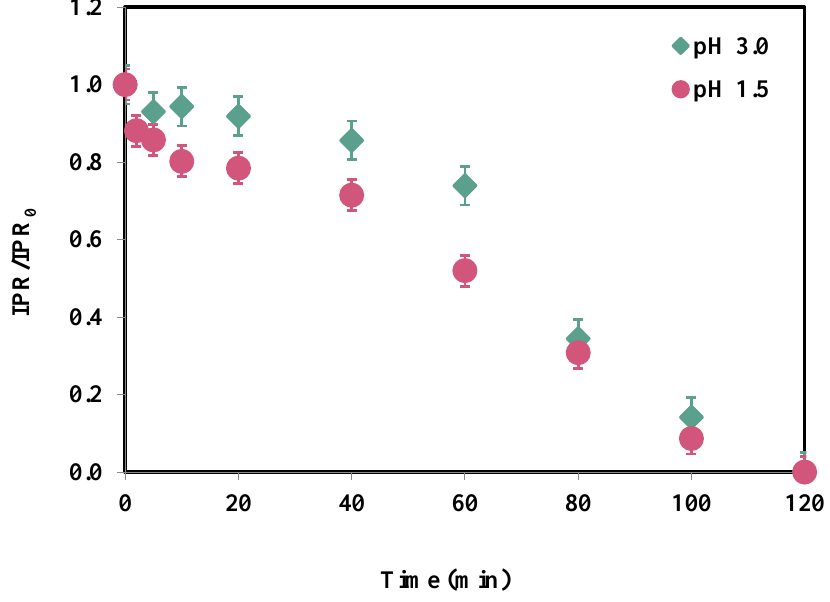
Figure 6. Changes in normalized IPR concentration during ZVA/PS treatments in DW at varying initial pH values. IPR = 2 mg/L; PS = 0.50 mM; ZVA = 1 g/L.